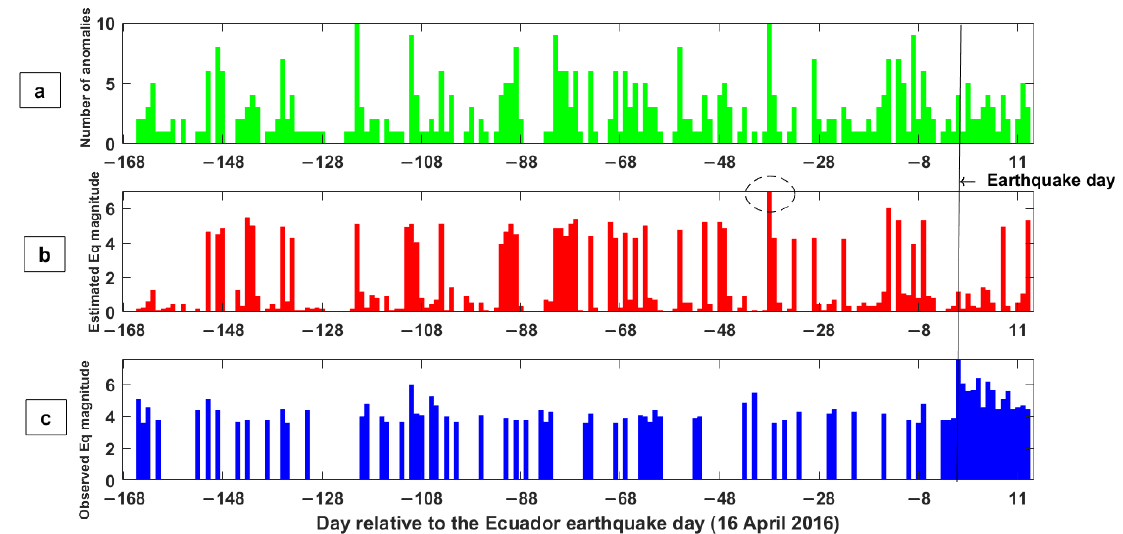
Figure 6. ( a ) Variation in the number of anomalies (green curve), ( b ) variation in the predicted earthquake magnitude (red curve), and ( c ) variation in the observed earthquake magnitude (blue curve) for the Ecuador earthquake (16 April 2016) from 1 November 2015 to 30 April 2016. In both panels, the x -axis represents the day relative to the earthquake day, which is indicated as a vertical dotted line. Figure 7a shows the daily variation in the number of detected anomalies (green curve) among 47 precursors and (b) the variation in the predicted earthquake magnitude (red curve) for the Iran earthquake (12 November 2017) from 1 August to 30 November 2017. The maximum number of detected anomalies (N = 13) was observed 19 days before the earthquake (Figure 7a). FIS estimated an earthquake with magnitude Mw = 7.02 (the black dotted ellipsoid in Figure 7b). The registered magnitude of the actual earthquake was Mw = 7.3.